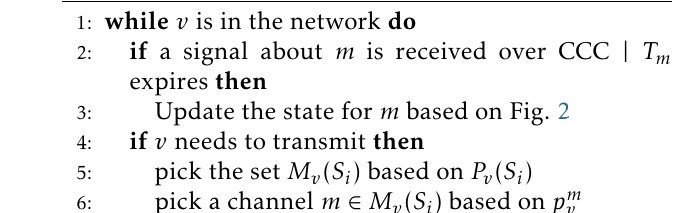
Algorithm 1 Order of channels for